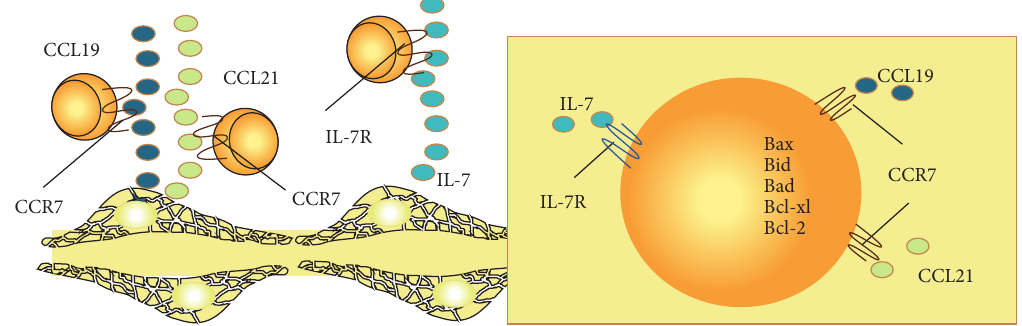
Figure 4: Il-7 in combination with CCL19 and CCL21 leads naive T cell to survival probably by acting in the imbalance of pro- and antiapoptotic